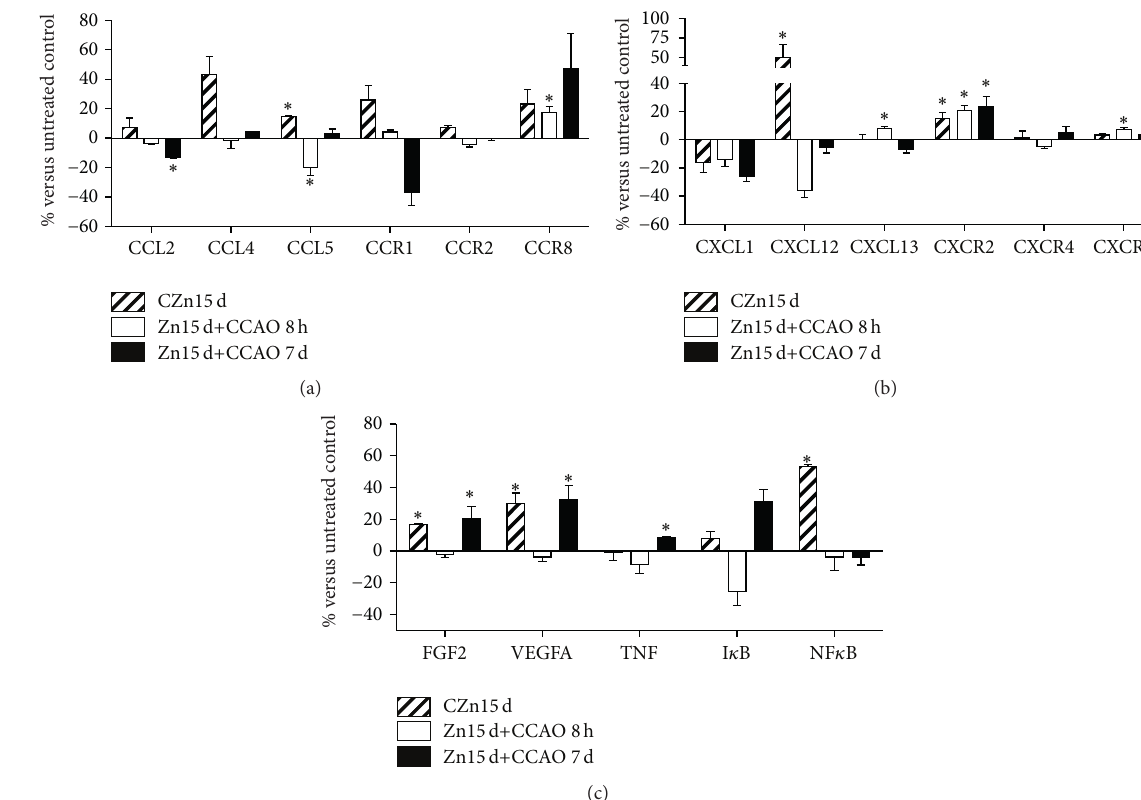
Figure 4: Effect of prophylactic chronic administration of zinc and CCAO on protein levels of chemokines and their receptors in the temporoparietal cortex-hippocampus using ELISA. CZn15d, rats with chronic administration of zinc; Zn15d+CCAO 8 h, rats with chronic administration of zinc before CCAO and evaluations at 8 h after reperfusion; Zn15d+CCAO 7 d, rats with chronic administration of zinc before CCAO and evaluations at 7 days after reperfusion. Experimental values were normalized with respect to those of untreated controls. Each value represents the mean ± SEM of 5 independent experiments made in triplicate. ∗ Significantly different from untreated rats (Student’s 𝑡 -test). The significance was established at 𝑃 < 0.05